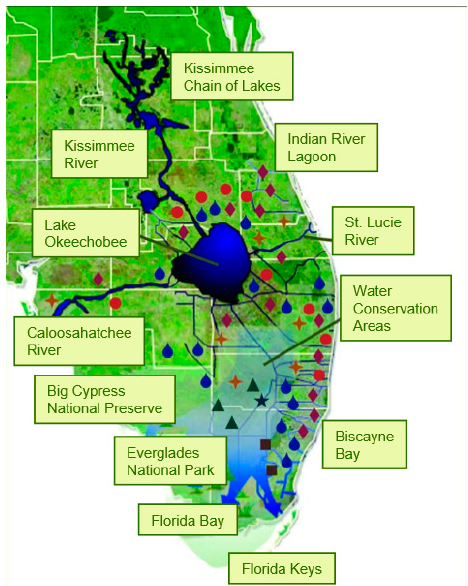
Figure 1. Map of southern Florida showing the locations of key geographic points and various projects within the Everglades Comprehensive Restoration Plan. The red dot above the Caloosahatchee River label is the Hendry County Reservoir.